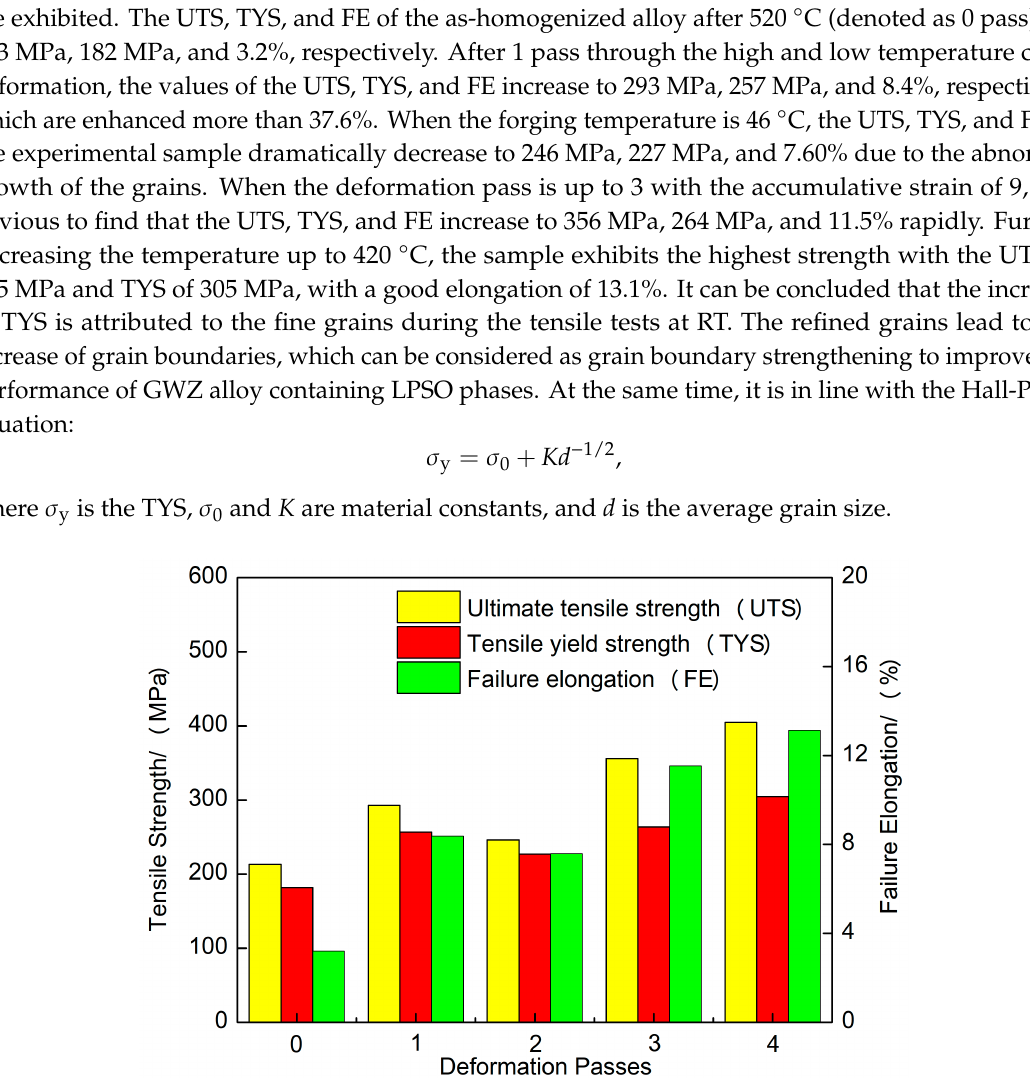
Figure 12. Tensile properties of the studied alloy after different deformation passes.